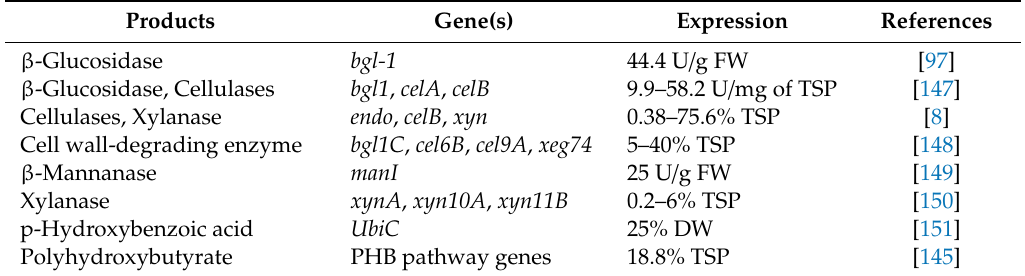
Table 6. Industrial enzymes and biomaterials obtained via chloroplast production in tobacco.